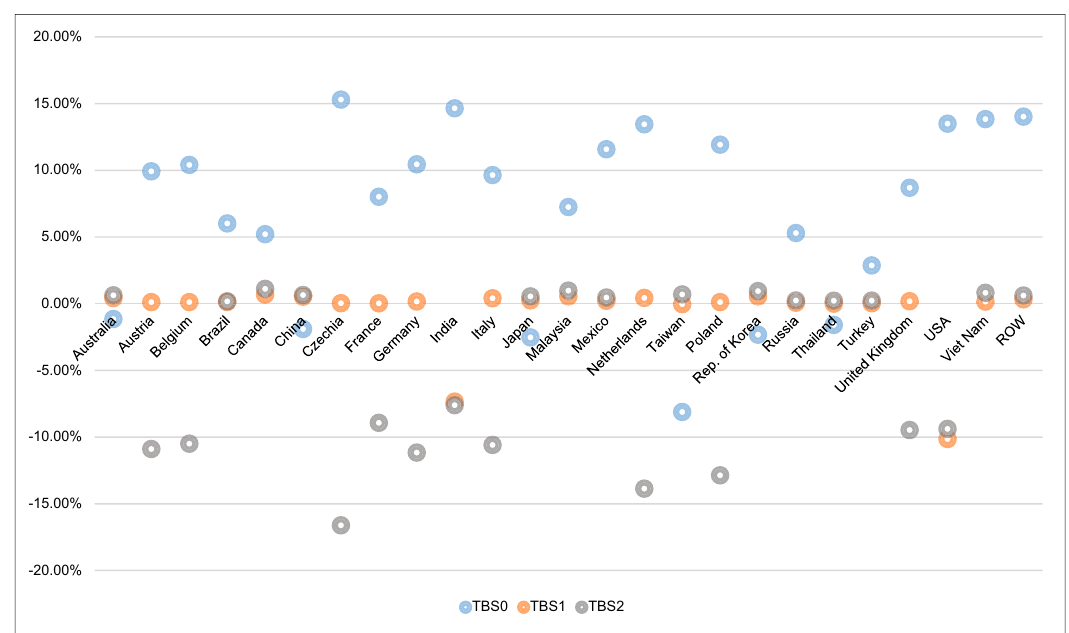
Fig. 6 Variation rates of solar cell and module application/installation in major trade partner countries/economies under the reduced trade barrier scenario (TBS0), the foreseeable higher trade barrier scenario (TBS1), and the intensi fi ed trade barrier scenario (TBS2). This fi gure re fl ects variation rates under TBS0, TBS1 and TBS2. The blue, orange and grey little circles represent variation rates of solar cell and module application/installation in major trade partner countries/economies under TBS0, TBS1 and TBS2, respectively. In TBS0 most countries/economies will see increasing solar photovoltaic (PV) installations. In TBS1 and TBS2, many countries/economies will suffer PV installation decreases due to higher trade barriers. ROW is the abbreviation for the rest of the